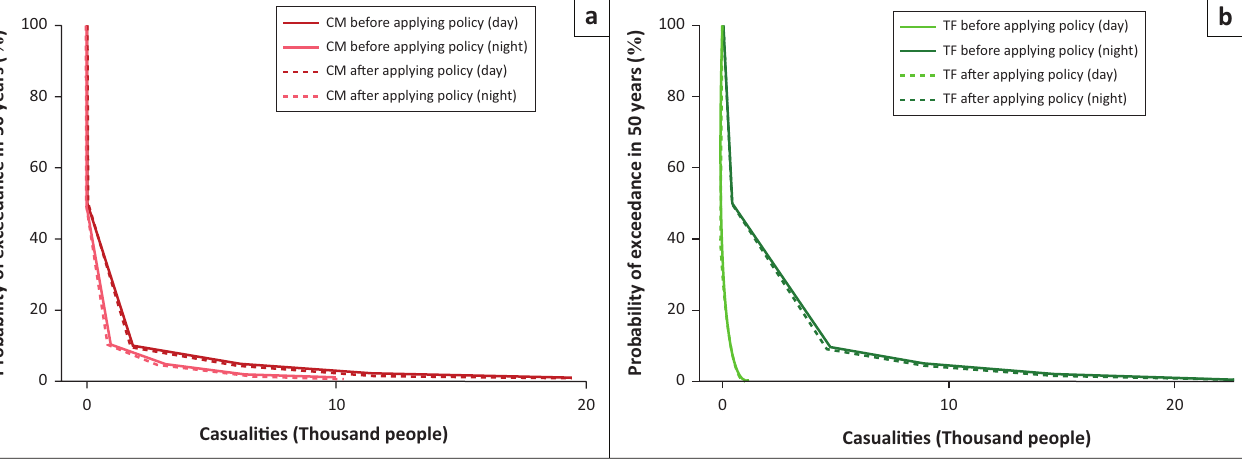
a b CM before applying policy